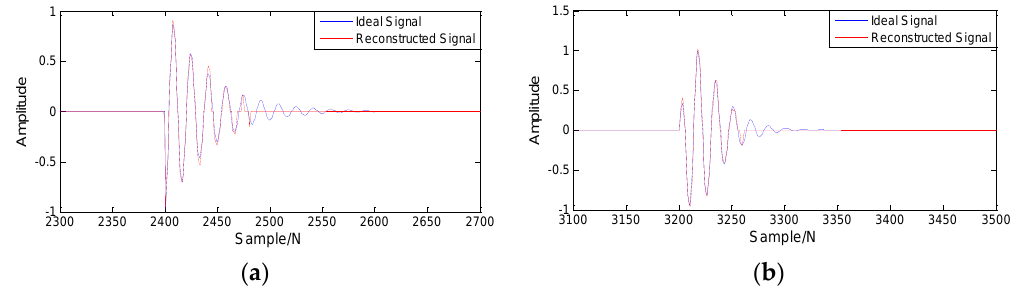
Figure 7. Detailed waveform comparison between the ideal noise-free PD signals shown in Figure 3a and the signals extracted from the noisy signal in Figure 3b by the CEEMDAN-Hankel-SVD method (Figure 6): ( a ) Simulated signal based on (16); and ( b ) Simulated signal based on (17). Here, the figures were placed in separate figures to facilitate detailed comparison.